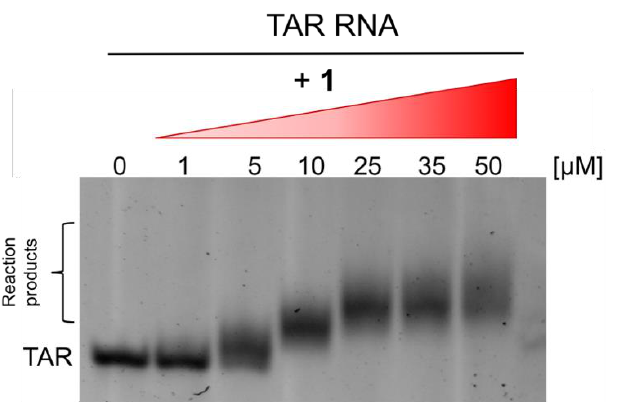
Figure 3. Non-denaturing polyacrylamide gel electrophoresis (PAGE) (PAA 12%) in TBE 1× showing the concentration-dependence of the interaction of B-CeP 1 with TAR. Folded TAR hairpin 1 μ M was incubated with increasing concentrations of compound (0, 1, 5, 10, 25, 35, 50 μ M) for 2 h at 37 °C with a BPE buffer (pH 7.4).